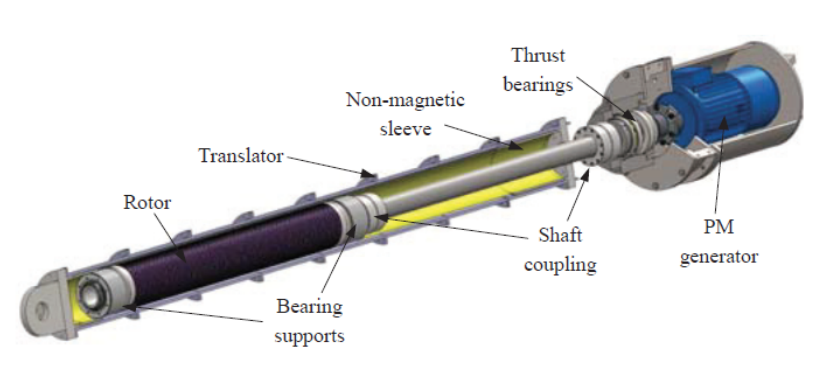
Figure 18. The magnetic lead screw for the Wavestar wave energy converter (WEC). From Holm, Design of a magnetic lead screw for wave energy conversion, XXth International Conference on Electrical Machines (ICEM) 2012. Copyright by IEEE. Reprinted by permission of